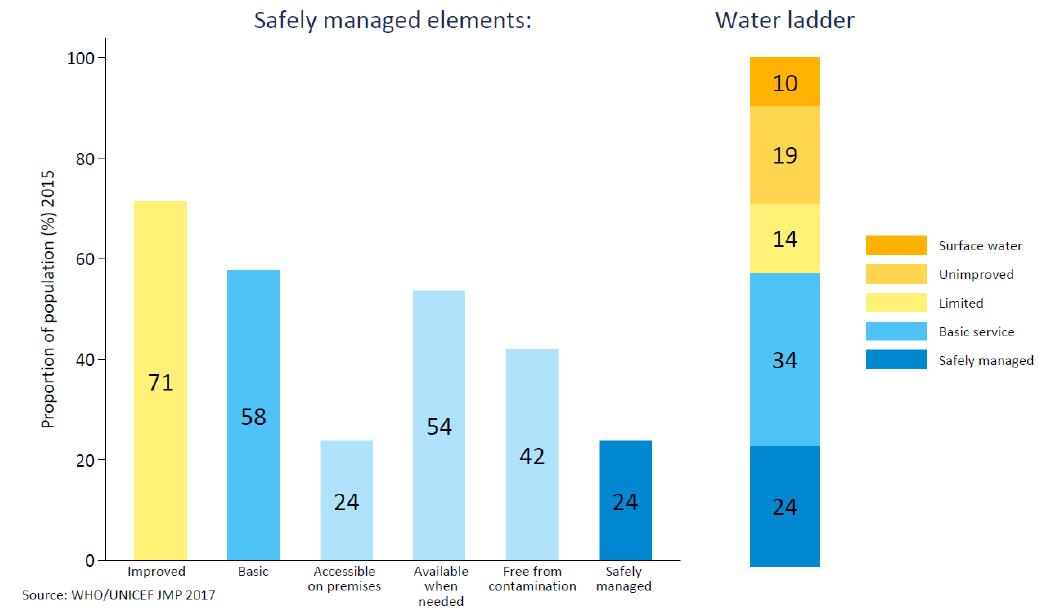
Figure 2. Estimation of safely managed drinking water services in sub-Saharan Africa. Source: WHO/UNICEF JMP (2017).